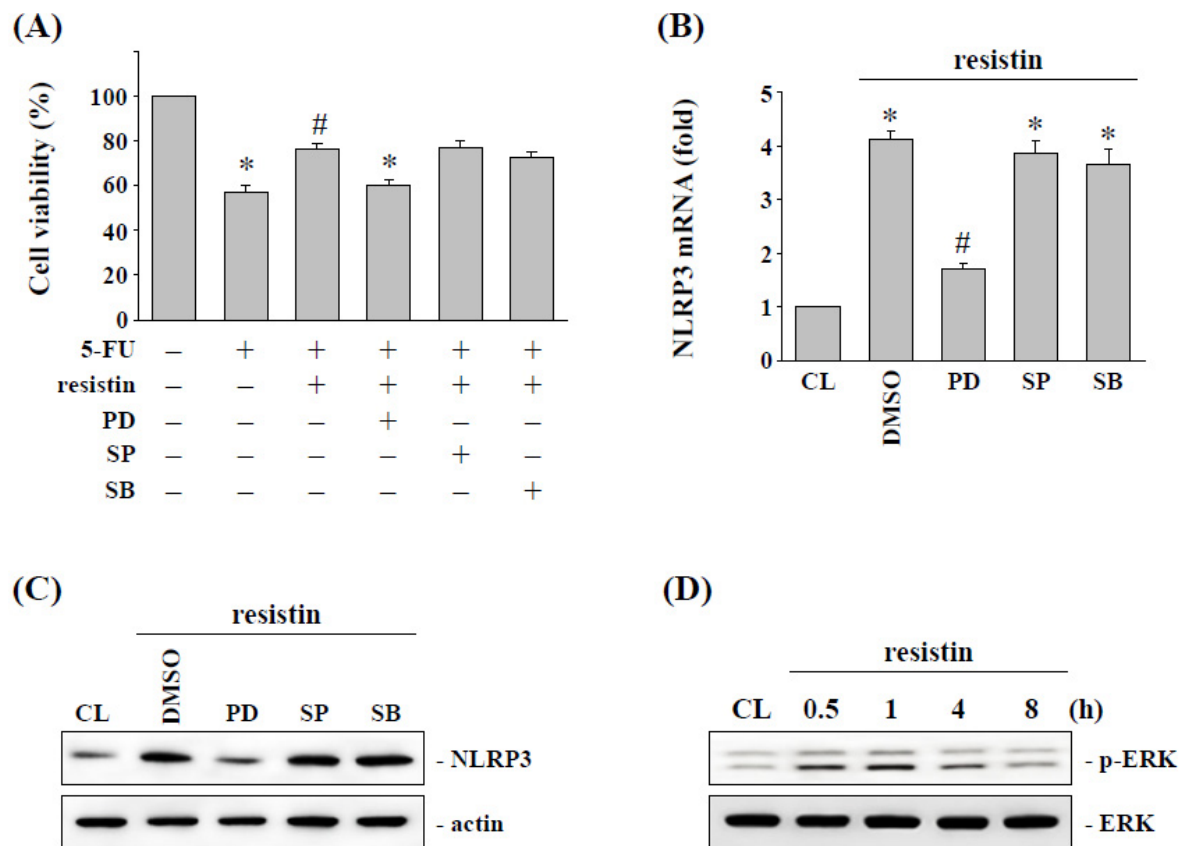
Figure 4. ERK signaling regulates resistin-increased NLRP3 expression and subsequent cell cyto- toxicity of HCT-116 cells. ( A – C ) HCT-116 cells were kept as the control (CL) or treated with resistin for 12 h, then cultured in 5-FU for a further 48 h. After being treated with resistin, HCT-116 cells were pretreated with specific inhibitors for ERK (PD98095), JNK (SP600125), and p38 (SB203580) and then treated with 5-FU. ( A ) Cell viability was assayed using the MTS assays. ( B ) The mRNA expression of NLRP3 was determined by real-time PCR. ( C )The protein expression of NLRP3 was determined by Western blotting. ( D ) HCT-116 cells were kept as the control (CL) or treated with resistin for the indicated times. The ERK phosphorylation was determined by Western blotting. Data in ( A,B ) are shown as mean ± SEM from three independent experiments. * p < 0.05 versus CL. # p < 0.05 versus DMSO/5-FU-treated cells. Results in ( C , D ) are representative of three independent experiments with similar results.